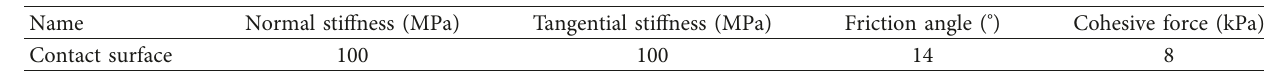
Table 4: Parameters of